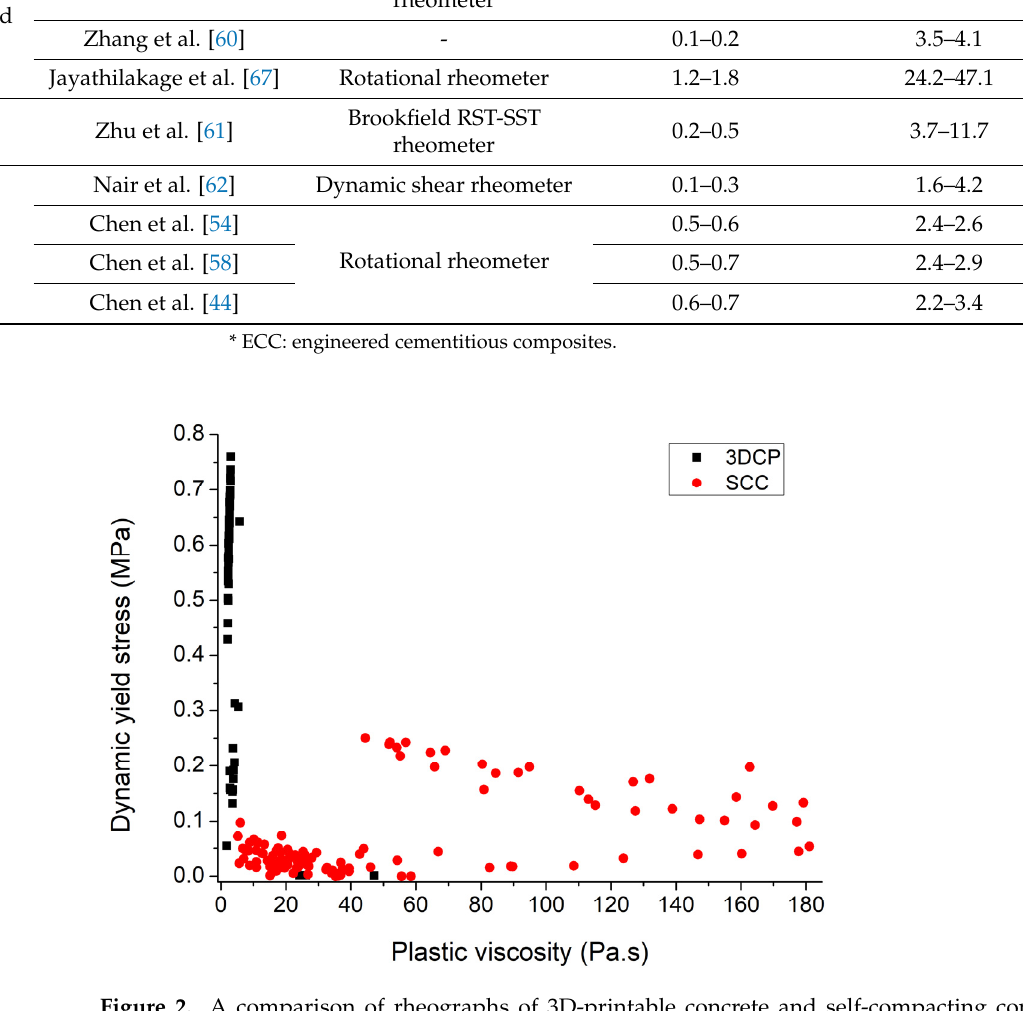
Table 2. Dynamic yield stress and plastic viscosity values reported in literature for different concrete inks.